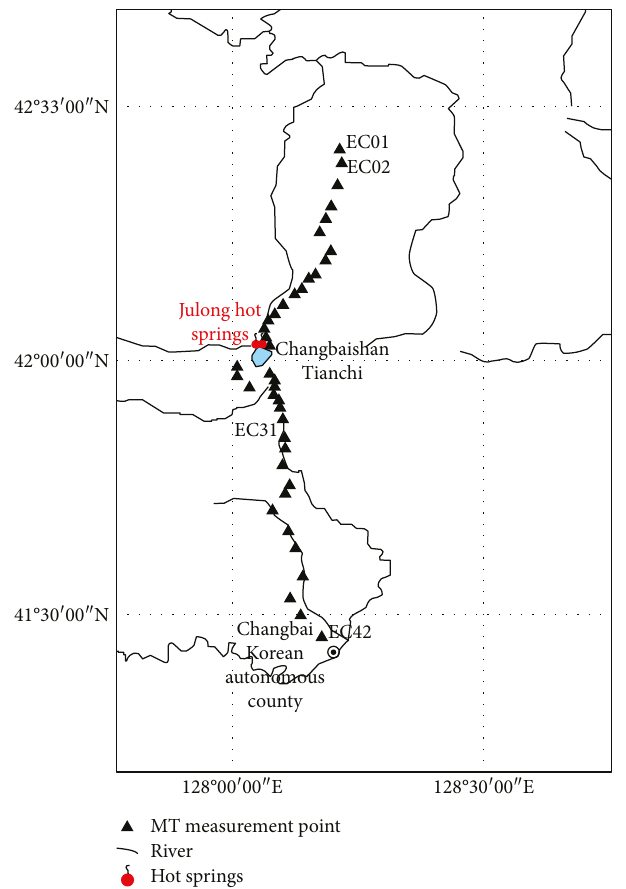
Figure 4: Distribution of MT station at the volcanic area in Changbai Mountain